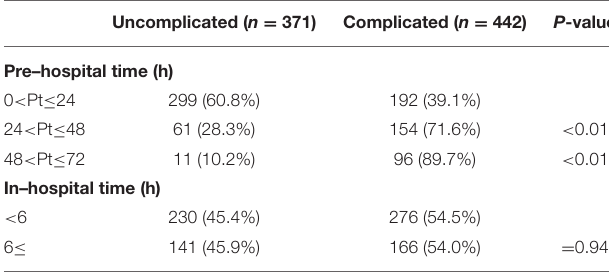
TABLE 2 | Demographics of 813 studied patients.